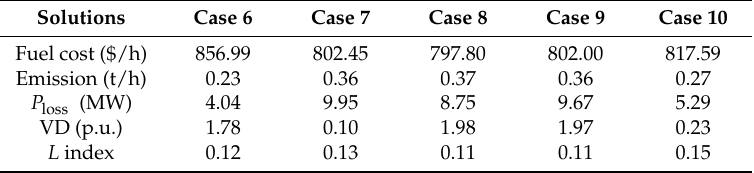
Table 10. Optimal solution of IEEE 30 bus power system for case studies 6 to 10.